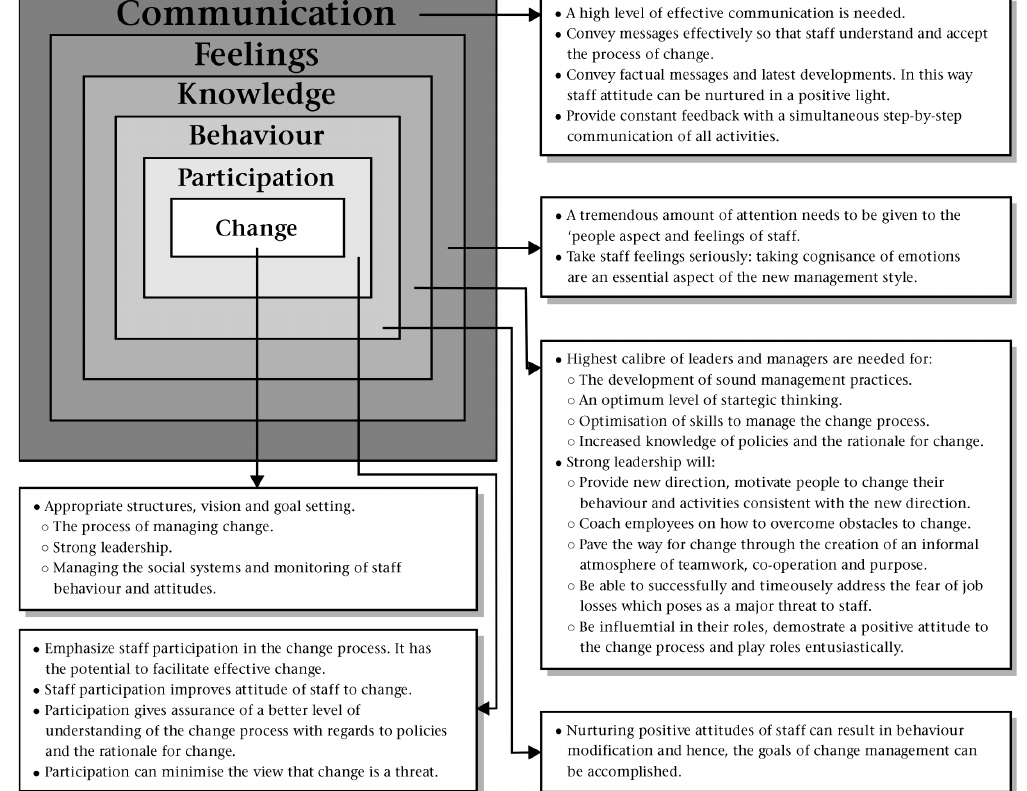
Figure 3: Recommendations for Effective Change